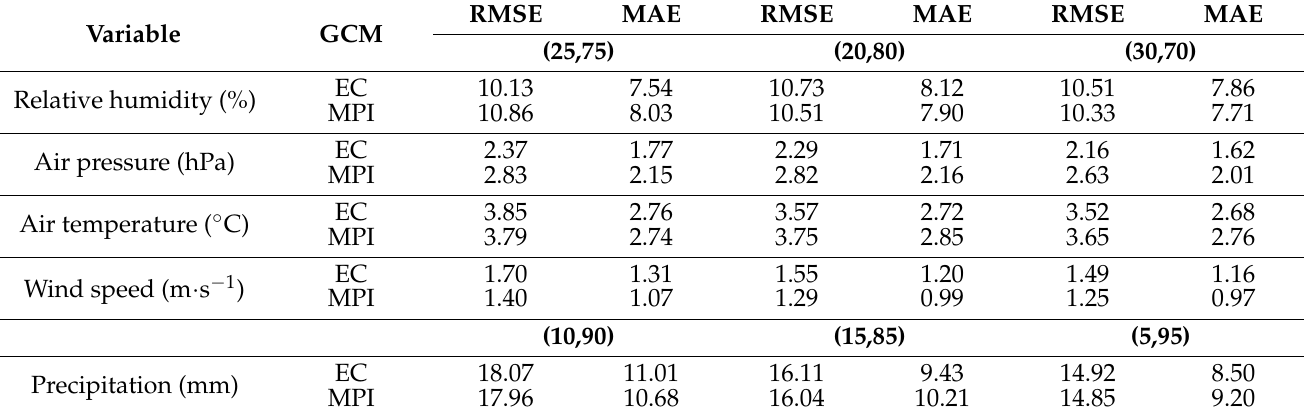
Table A4. RMSE and MAE values measured at the Shiquan River site between the calibrated results and the monthly observations in the 1985–1999 period using different pairs of quantiles: (25,75), (20,80), (30,70), except for precipitation where (10,90), (15,85) and (5,95) were compared. Same as Table A2 but at the Shiquan River site.